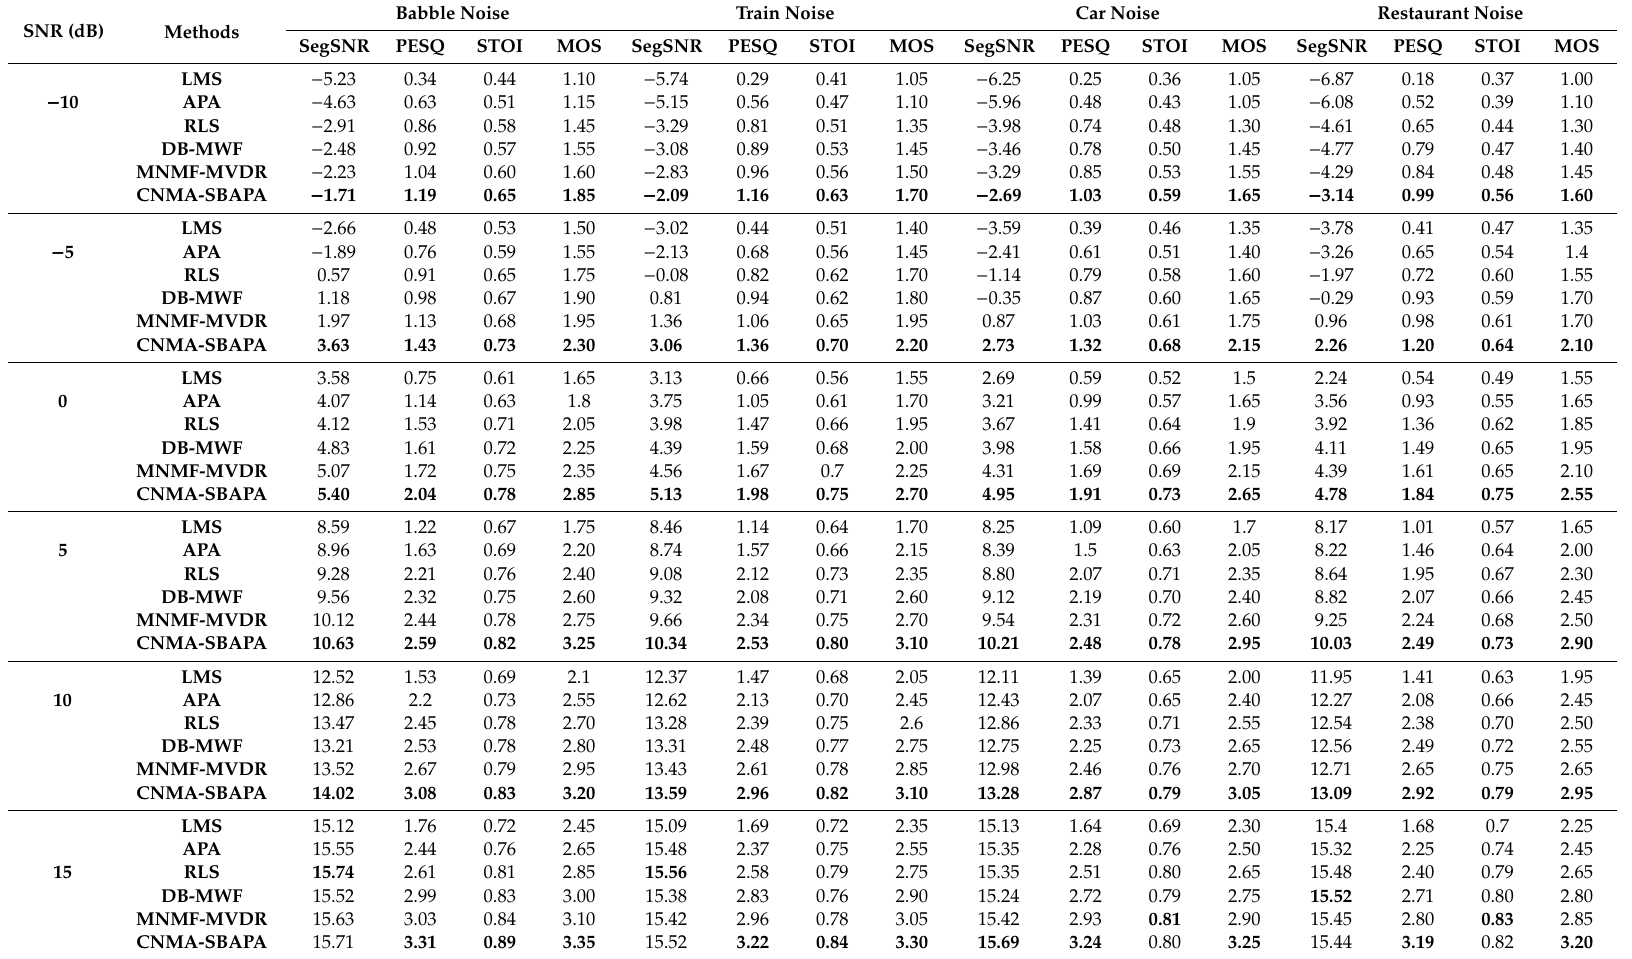
Table 4. The comparison between PESQ, MOS, STOI, and SegSNR for the proposed CNMA-SBAPA in comparison with the LMS, traditional APA, RLS, DB-MWF, and MNMF-MVDR methods on the simulated data for colored noises such as: train, babble, car, and restaurant noises in di ff erent range of SNRs (the bold numbers are the best